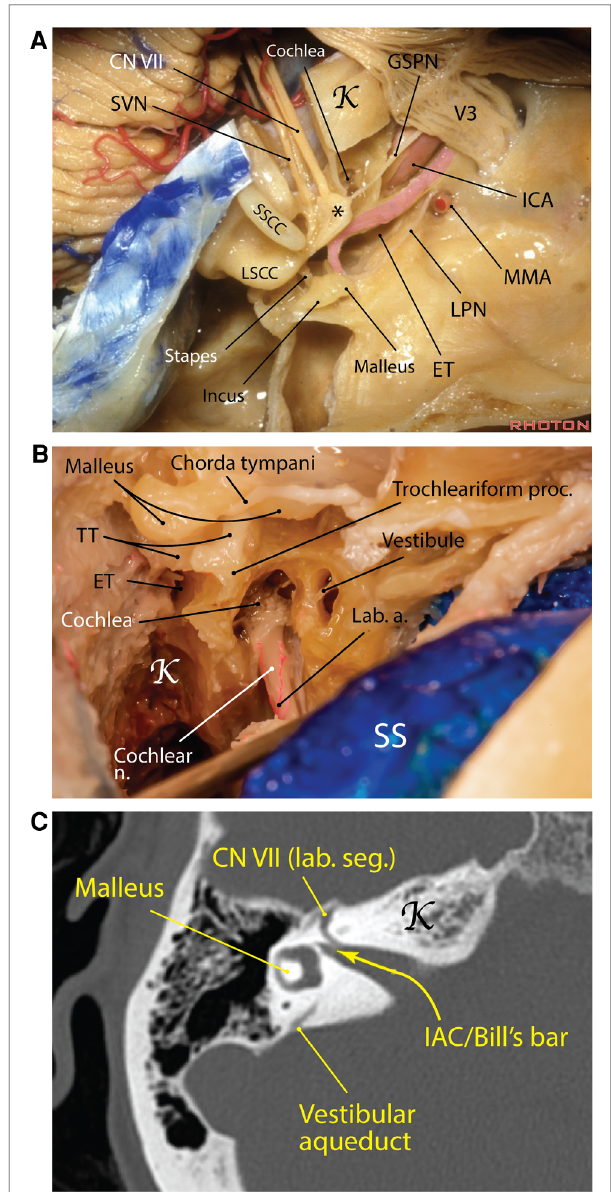
FIGURE 5 Carotid canal Eustachian tube in the middle cranial fossa. ( A ) The carotid canal starts at the exocranial surface of the temporal bone anteromedial to the jugular foramen. The GSPN runs on top of the petrous ICA and a thin shell of bone may separate the two. The Eustachian tube runs parallel and lateral to the carotid canal and harbors the tensor tympani muscle (pink area). *Geniculate ganglion [Courtesy of The Rhoton Collection , American Association of Neurological Surgeons (AANS)/Neurosurgical Research and Education Foundation (NREF)]. ( B ) A right mastoidectomy exposing the middle ear structures and the posterior end of the Eustachian tube, which is adjacent to the trochleariform process (Courtesy of Barrow Neurological Institute. Used with permission). ( C ) Right temporal bone computed tomography showing the internal auditory canal and the vertical crest (aka Bill ’ s bar). a., artery; CN, cranial nerve; ET, Eustachian tube; GSPN, greater super fi cial petrosal nerve; ICA, internal carotid artery;